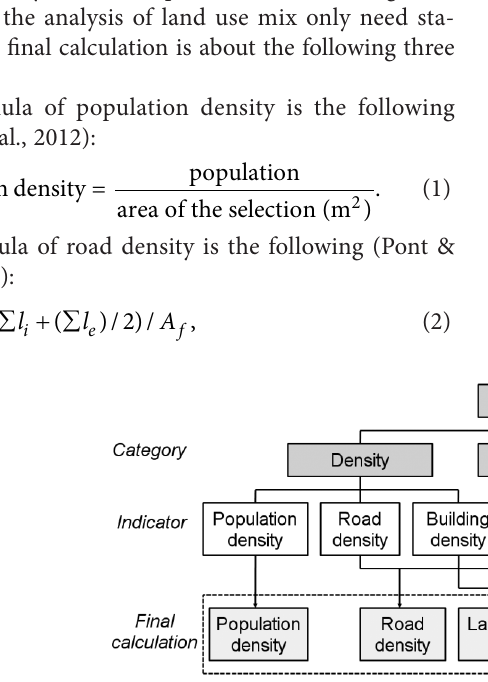
Figure 2. Simplification process of DMA indicator system (figure drawn by the